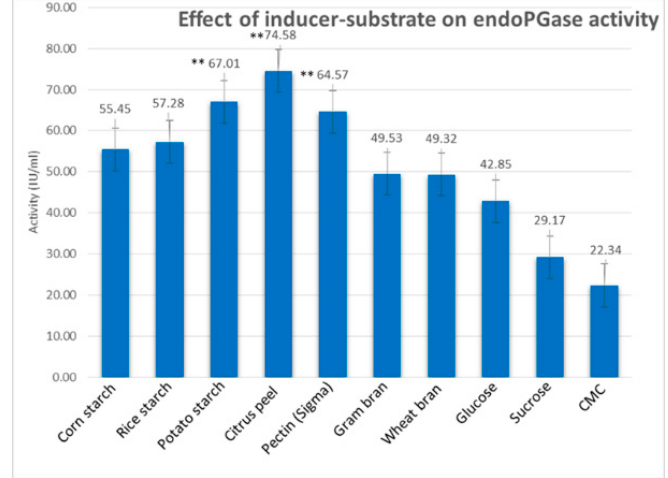
Figure 7. Effect of agro-based monomeric and dimeric substrates on endopolygalacturonase activity. ** The mean values are highly significant at 1% level of significance with a p -value of 0.05 representing the highest significant effect of citrus peel in comparison with potato starch and pectin (Sigma) on EndoPGase